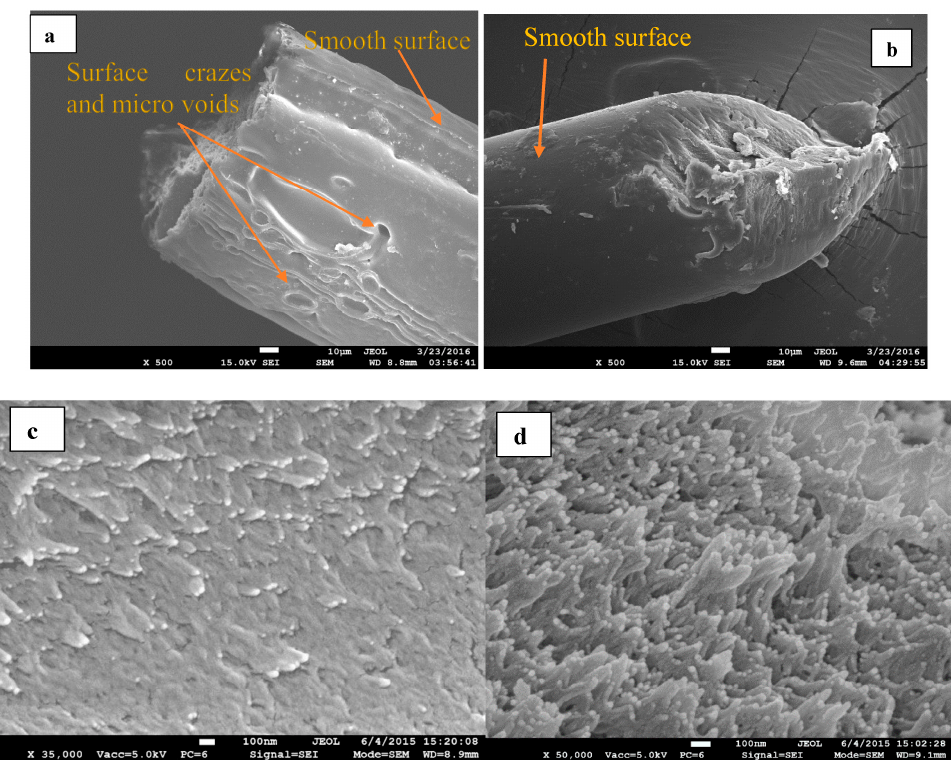
Figure 5. SEM image of a cross section of ( a ) neat CA fiber ( b ) CA-MWCNT 0.5 wt. % fiber.